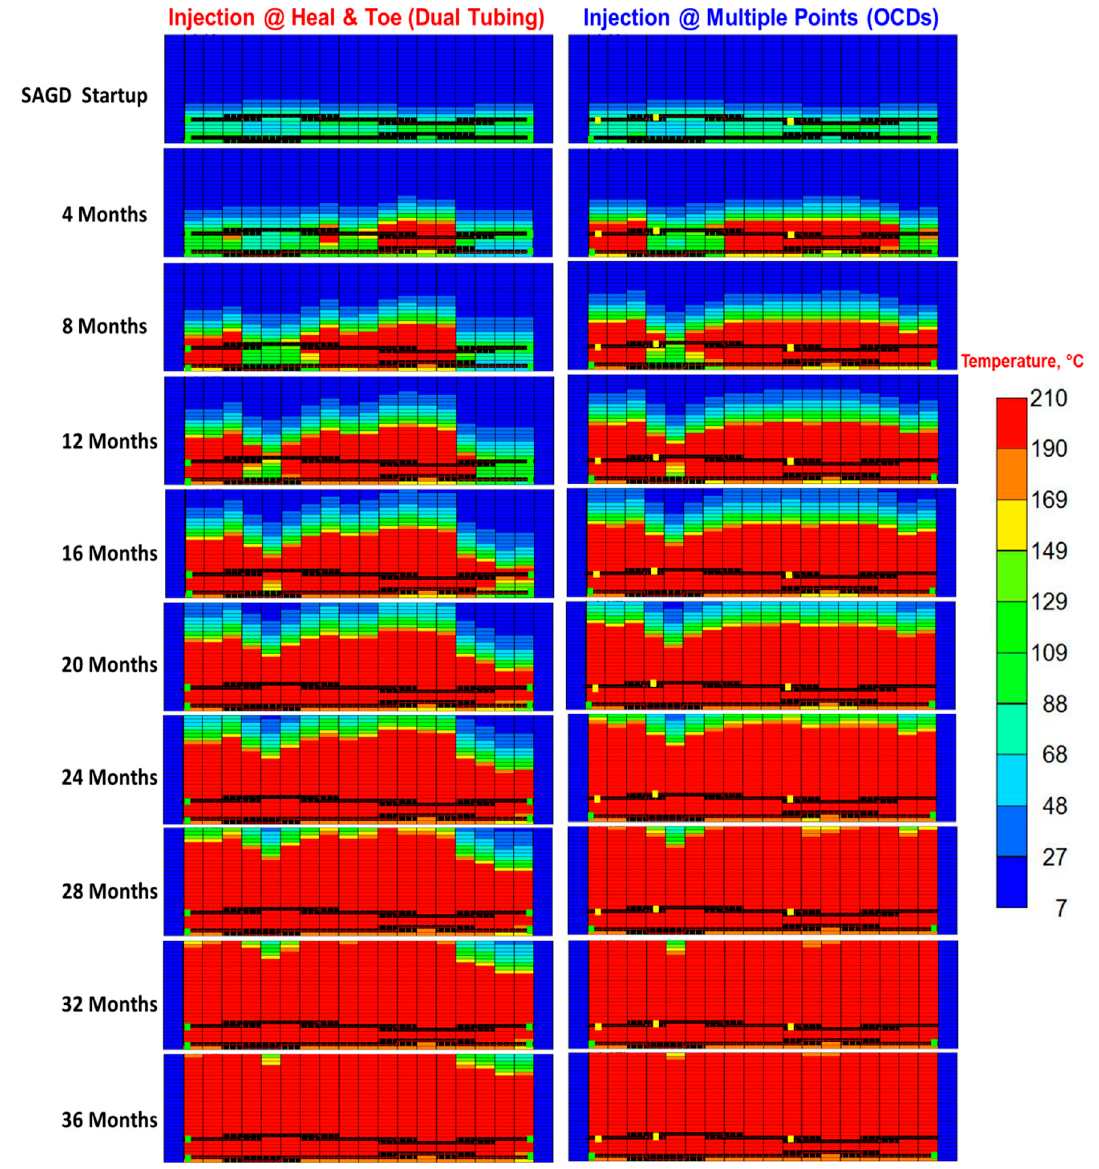
Figure 13. Steam chamber growth of the optimized OCD and dual ‐ string cases.